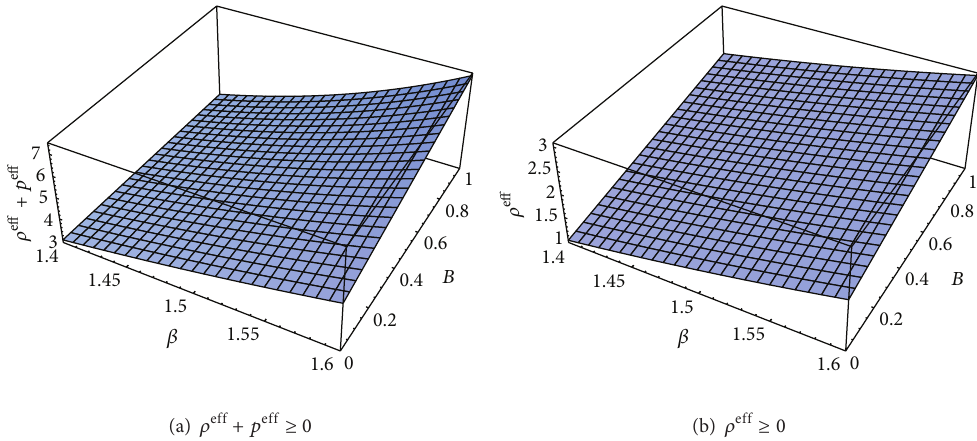
Figure 1: Plot (a) shows 𝜌 eff + 𝑝 eff ≥ 0 versus 𝛽 and 𝑀 0 . Plot (b) represents 𝜌 eff ≥ 0 versus parameters 𝛽 and 𝐵 with 𝑀 0 = 0.2 . In both cases, we take the present values of cosmological parameters with 𝐶 1 = 1 , 𝐶 2 = 2 .